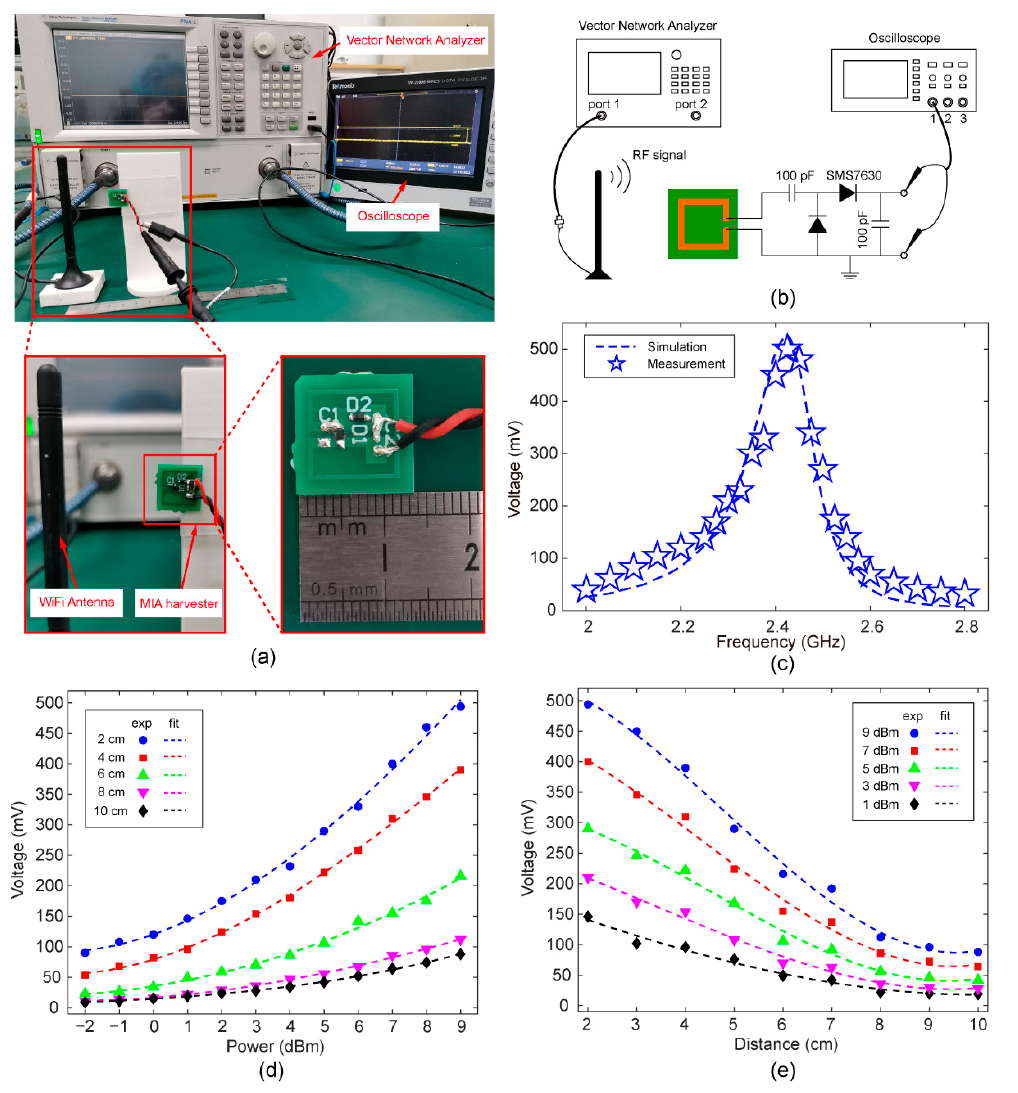
Figure 5. ( a ) Experimental setup for the output voltage of WiFi energy-harvesting MIA. ( b ) Schematic diagram of the experimental setup. ( c ) Simulated (blue dotted line) and measured DC output voltage spectrum (blue pentagram) of the MIA harvester. ( d ) The relationship between measured output voltages and input RF powers for different distances. ( e ) The relationship between measured output voltages and distance under conditions of different input RF powers. The experimental results and polynomial fitting results are represented by dotted lines and markers, respectively.